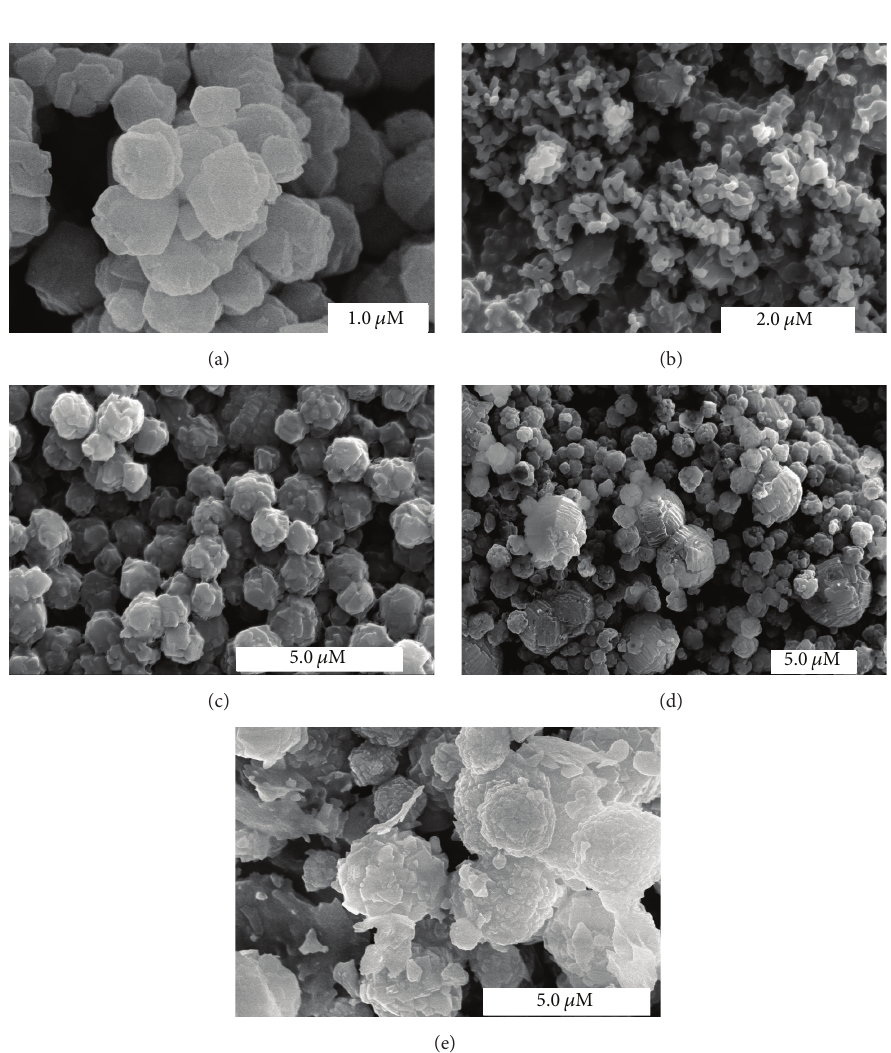
Figure 3: The SEM images of the samples with different H 2 SO 4 /Al 2 O 3 and different crystallization time. (a) NaY-0-12; (b) NaY-0.67-24; (c) NaY-0.67-48; (d) NaY-0.67-144; (e)